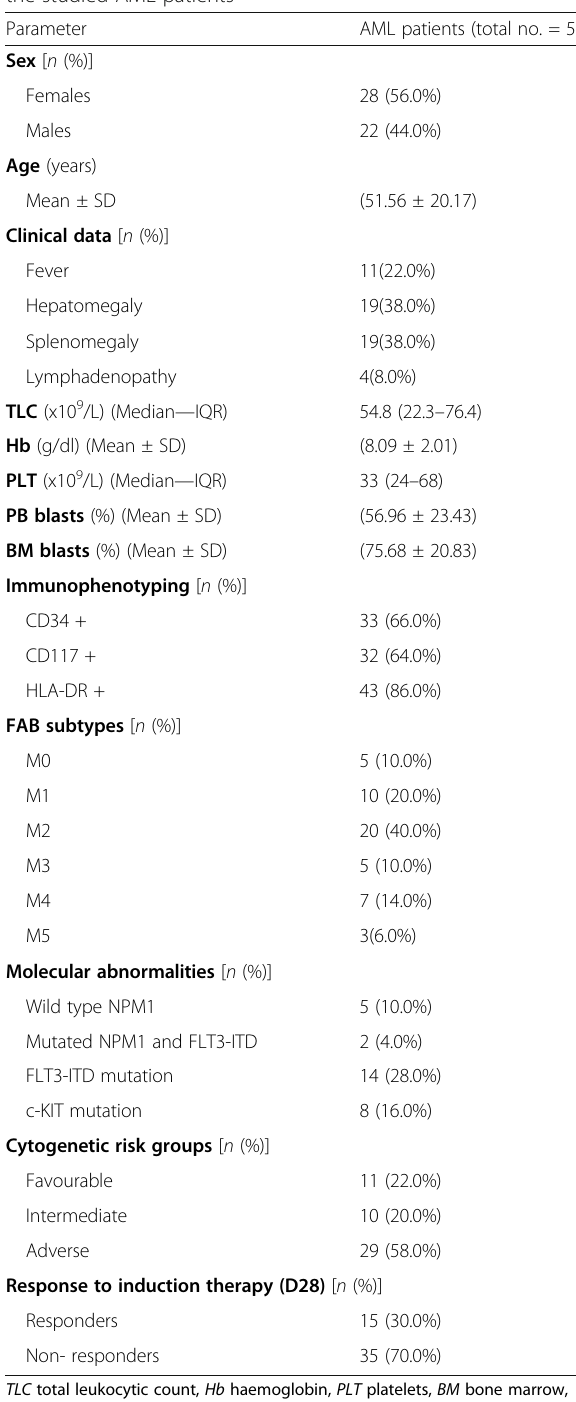
Table 1 Demographic, clinical, and laboratory characteristics of the studied AML